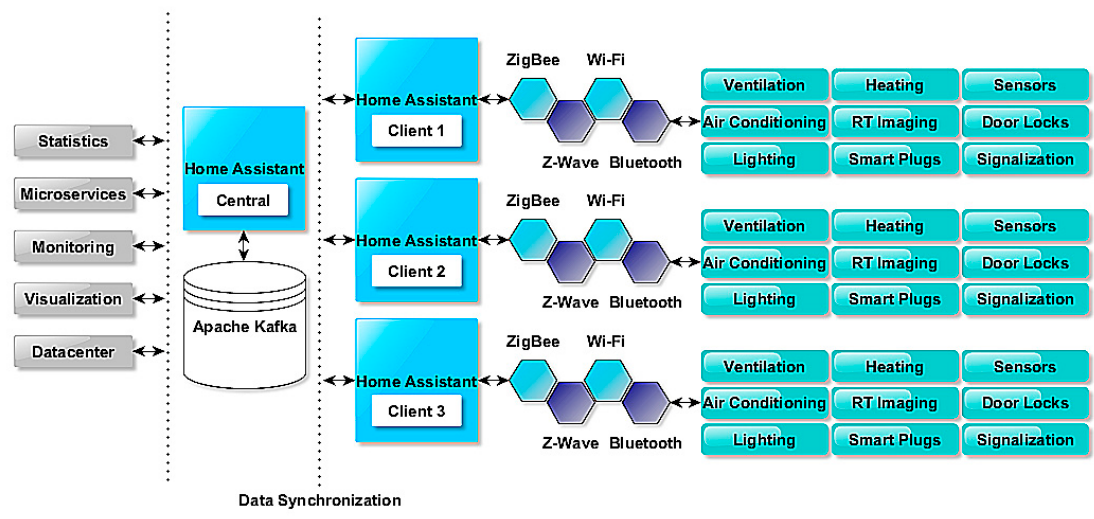
Figure 1. Structure of created system.